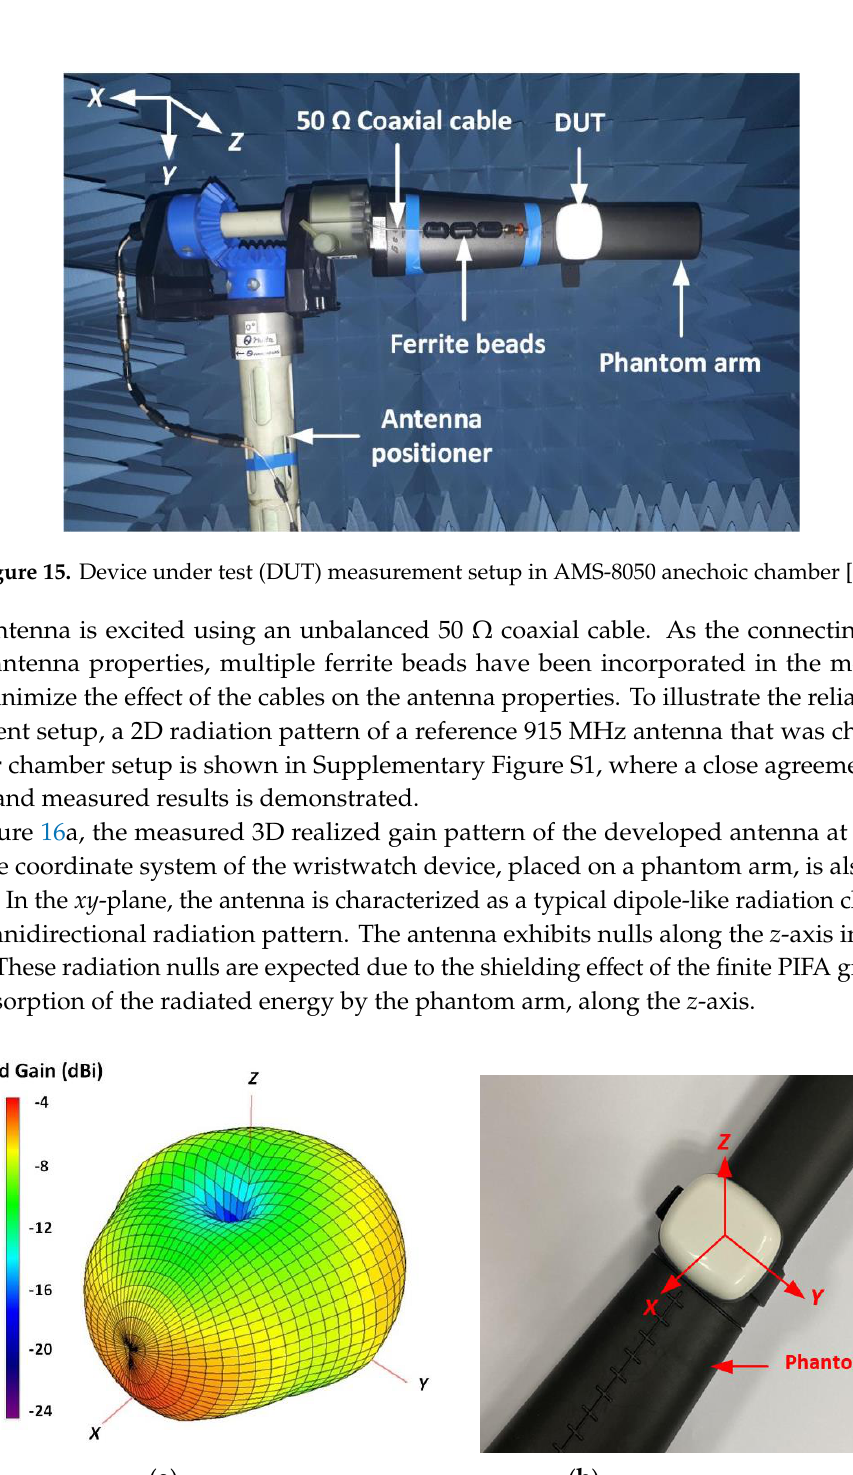
Figure 14. Measured S 11 response of the antenna.